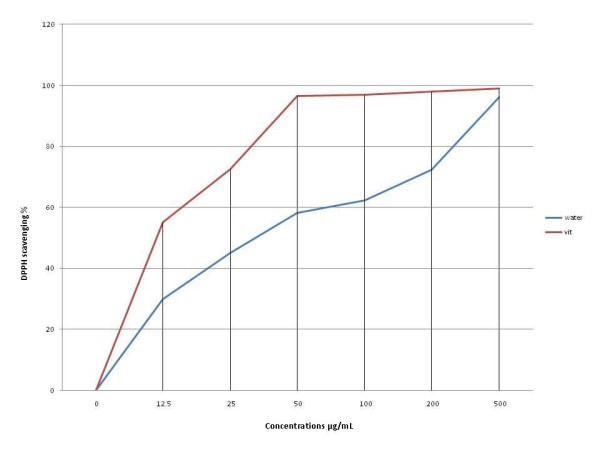
DPPH radical scavenging activity of water extract of Ps. Observation as IC50.